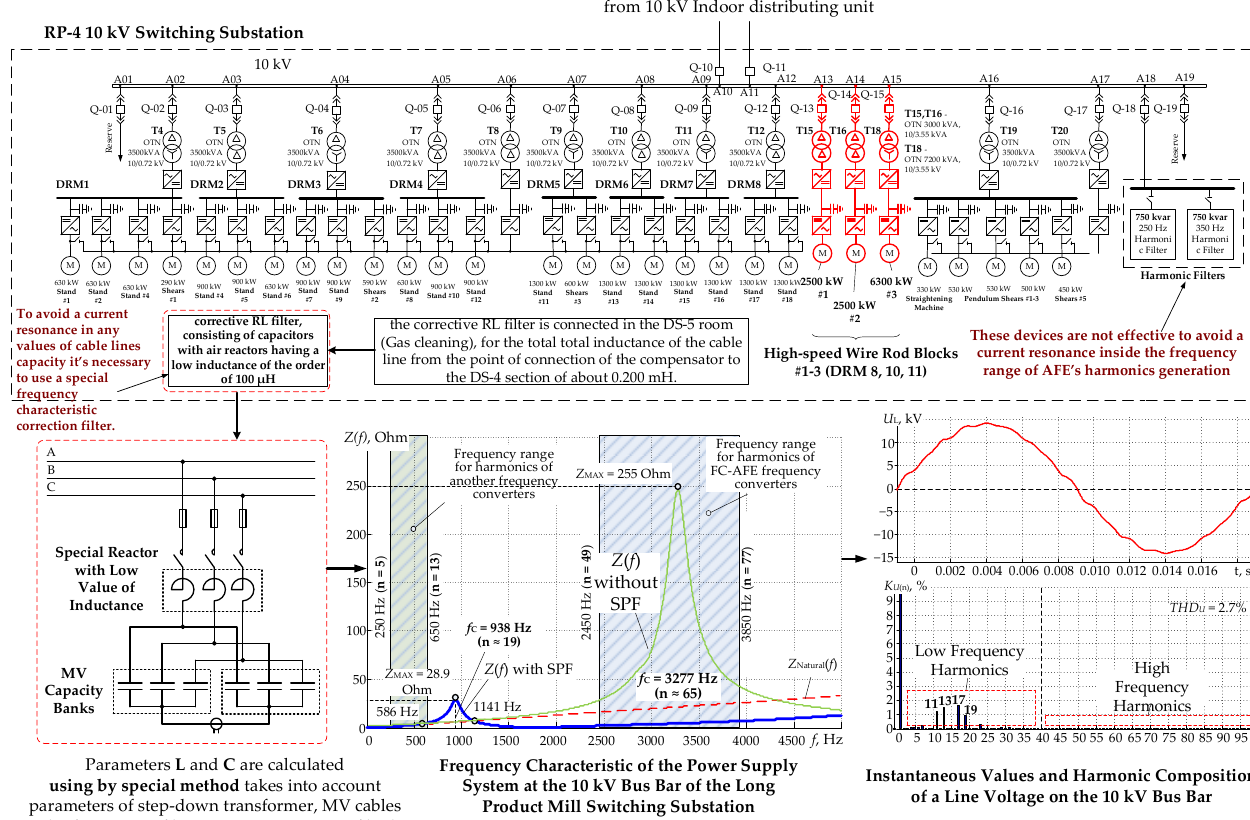
Figure 23. The adjustment of the frequency response of the power supply system by applying an SPF.